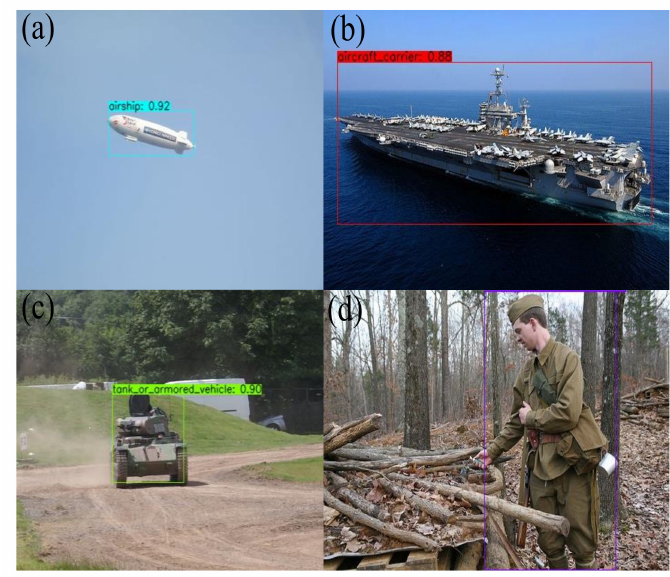
Figure 8. Object detection results. ( a ) airship; ( b ) aircraft carrier; ( c ) tank; ( d ) uniformed soldier.